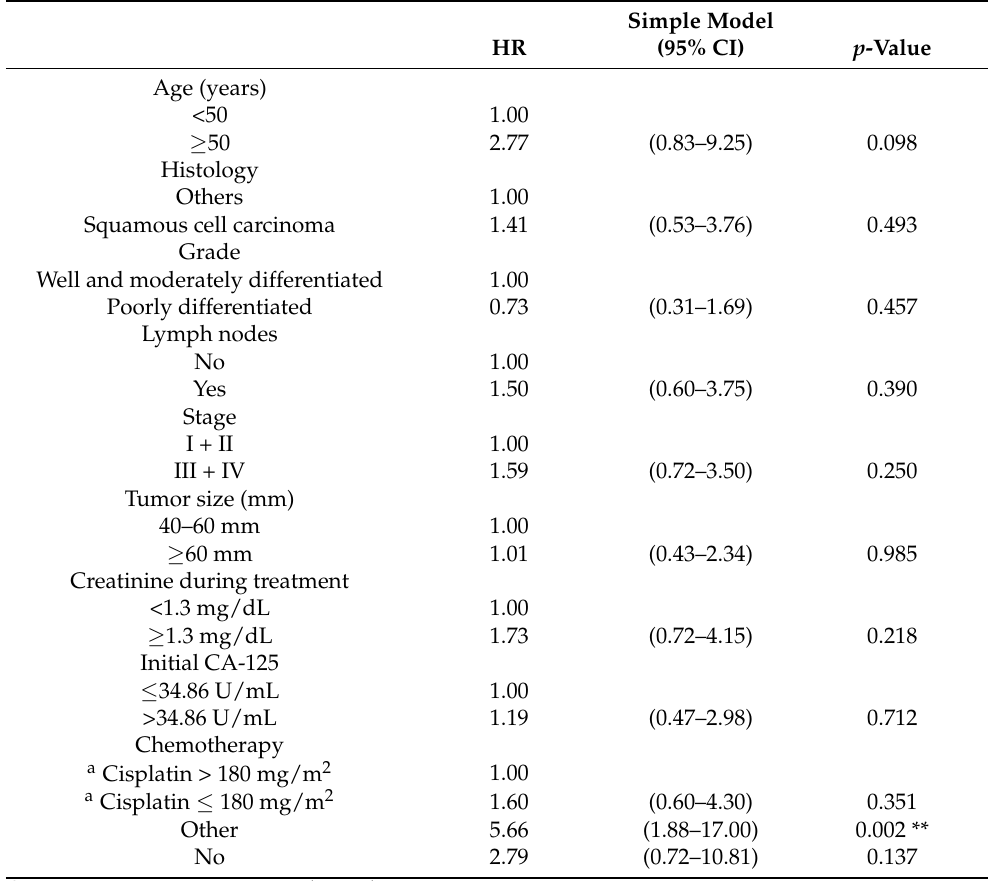
Table 4 summarizes the univariate analysis of death. Cumulative cisplatin > 180 mg/m 2 was also associated with a better outcome when compared with other regiments. Table 4. Univariate analysis of